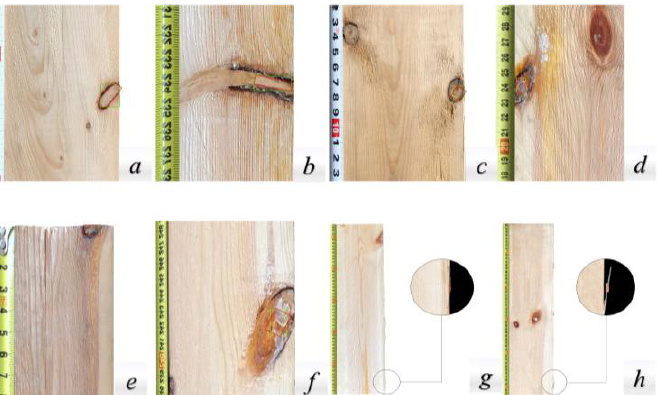
Figure 8. The interference factors on the measurement of the minimum enclosure rectangle of lumber: ( a ) type: spike knot; ( b ) type: spike knot; ( c ) type: round knot; ( d ) type: round knot; ( e ) type: end knot; ( f ) type: end knot; ( g ) type: rough saw cut; ( h ) type: rough saw cut.